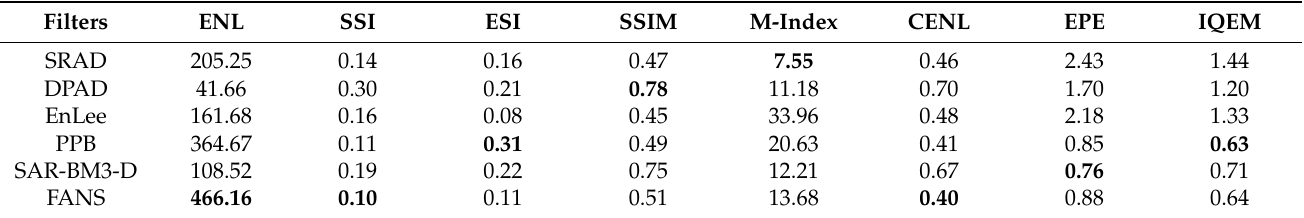
Figure 10. ( a1 ) Noisy RadarSAT-2 SAR image. Filtered images by the ( b1 ) SRAD filter, ( c1 ) DPAD filter, ( d1 ) EnLee filter, ( e1 ) PPB filter, ( f1 ) SAR-BM3-D filter, and ( g1 ) FANS filter. ( a2 – g2 ) are the enlarged images of region 1 from ( a1 – g1 ). ( e3 , g3 ) are the enlarged images of region 2 from ( e1 – g1 ). Table 6. Index evaluation of the RadarSAT-2 SAR image.